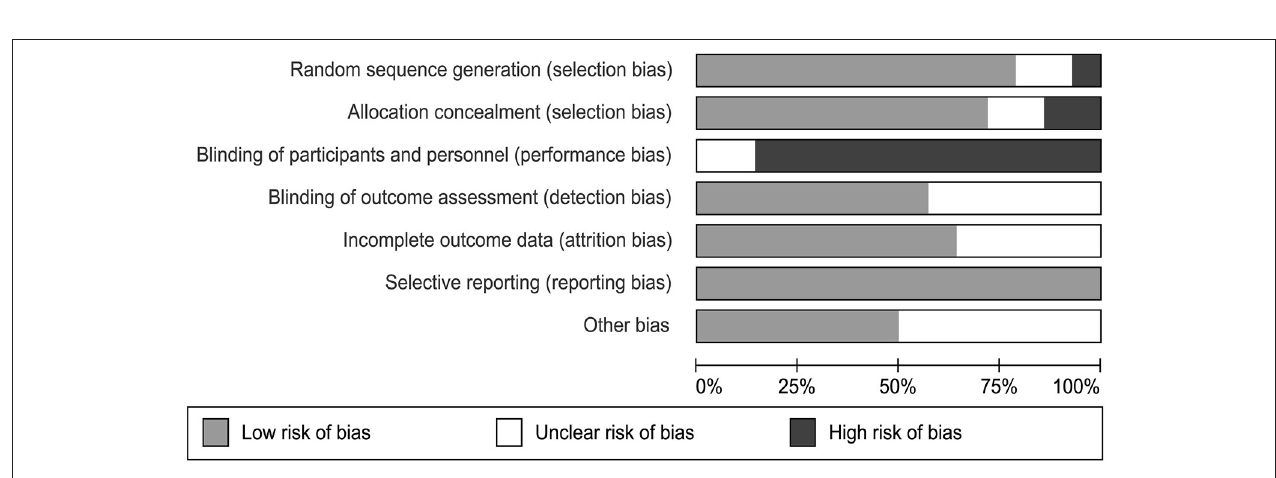
FIGURE 2 | Risk of bias in the included